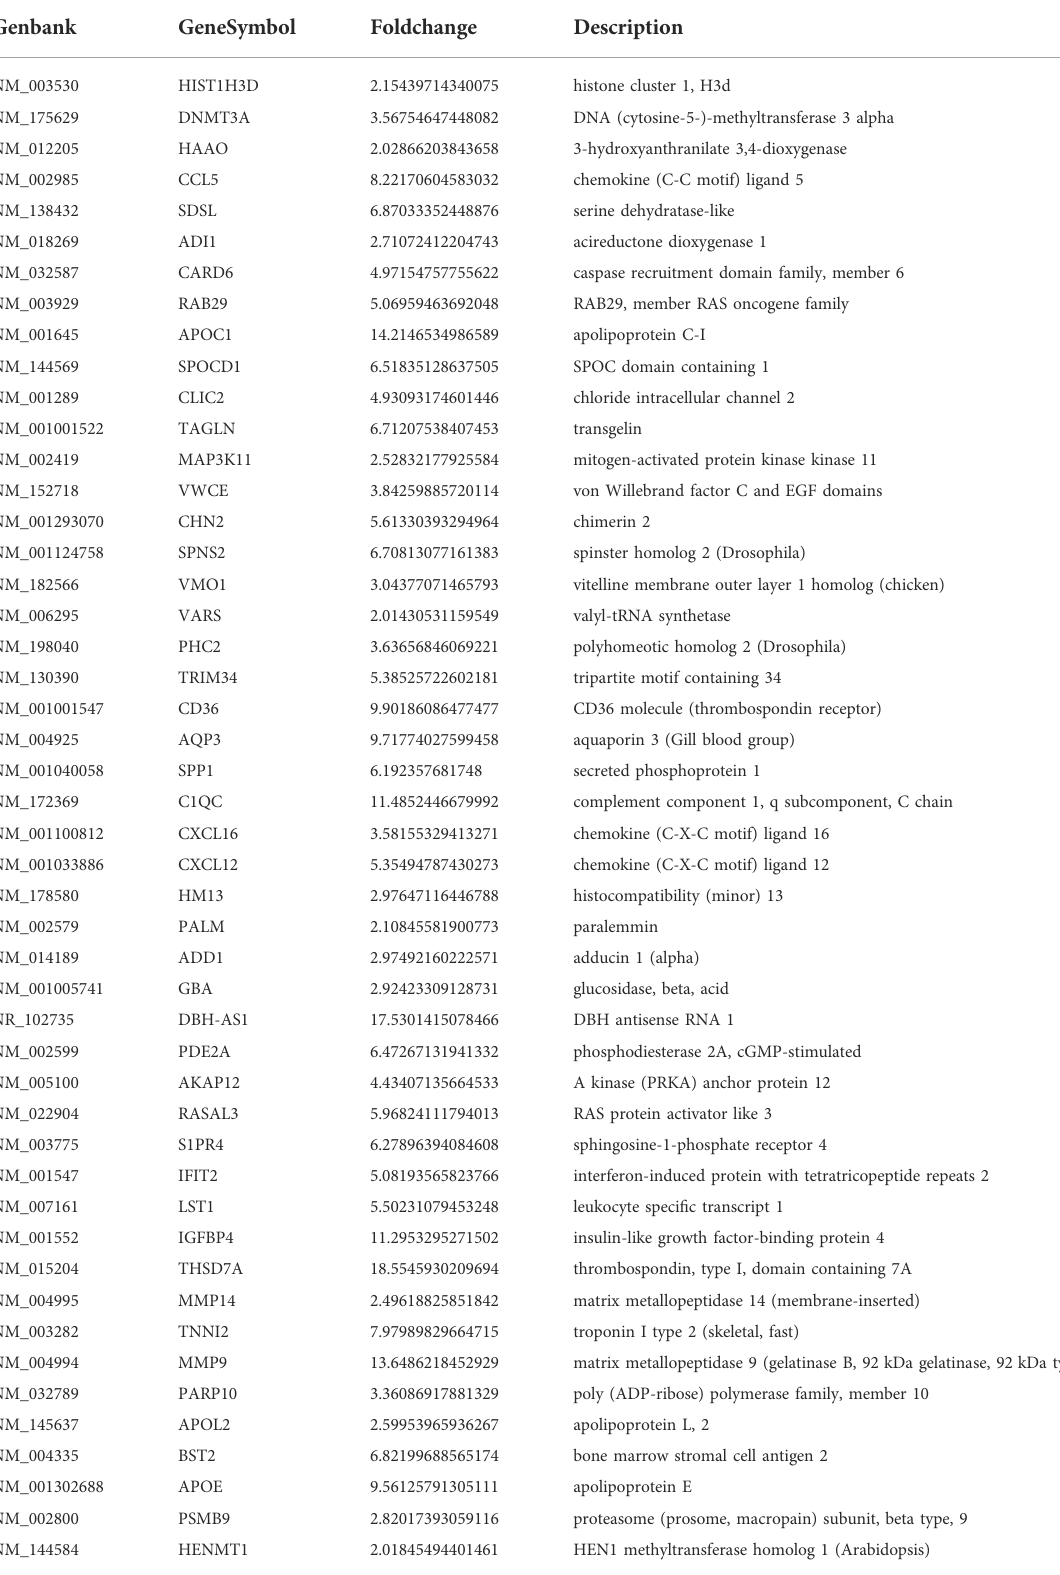
TABLE 1 Differentially expressed genes were up-regulated (Fold change >